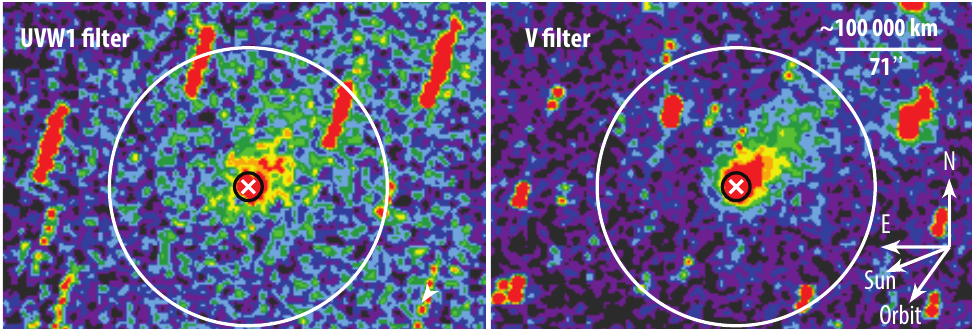
Figure 5. UVOT monitored the water production rates of the first active interstellar comet 2I/Borisov throughout the inner solar system by combining UVW1 ( left ) and V-band filter ( right ) observations. These observations were acquired on 21 December 2019, when the comet was at 2.03 au from the sun and 1.94 au from Earth, after